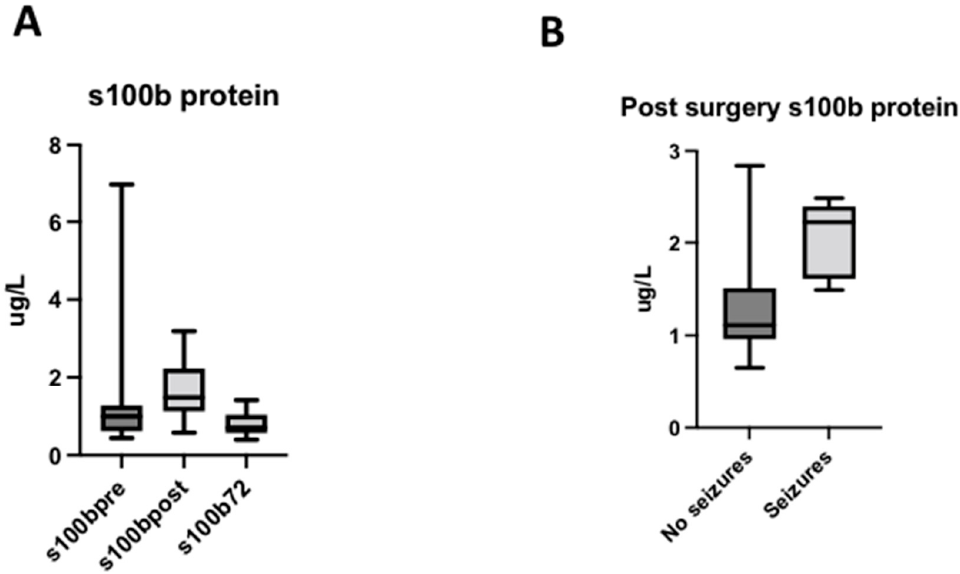
Figure 3. Levels of S100B protein. ( A ) Evolution of S100B protein in the perioperative period. ( B ) Levels of S100B protein depending on the presence of electrical seizures during the surgery.